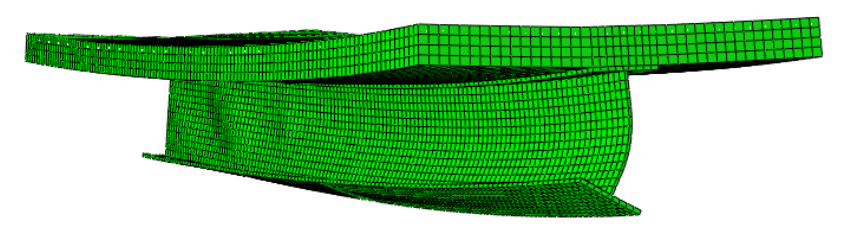
Figure 17. Web distortion detail for model 6, axial released